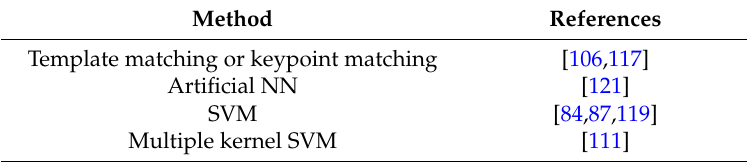
Table 9. Methods for classification in the counterfeit banknote detection process flow.